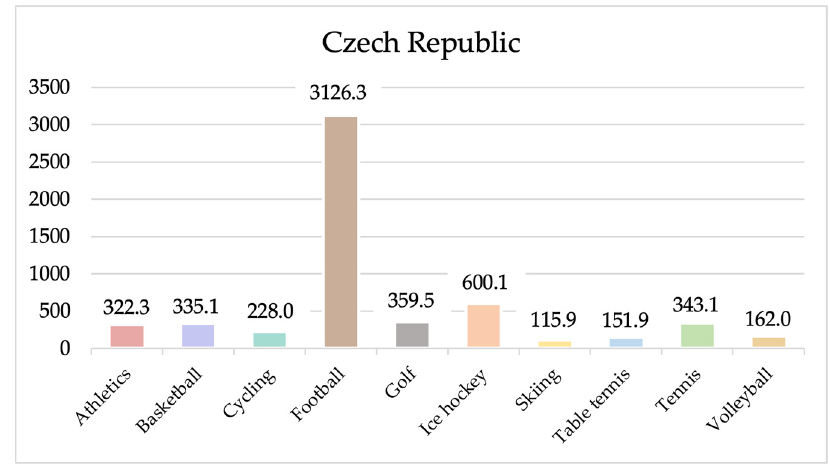
Figure 3. Registered athletes per 100,000 inhabitants: Czech Republic; Source: (Czech Statistical Office 2022).